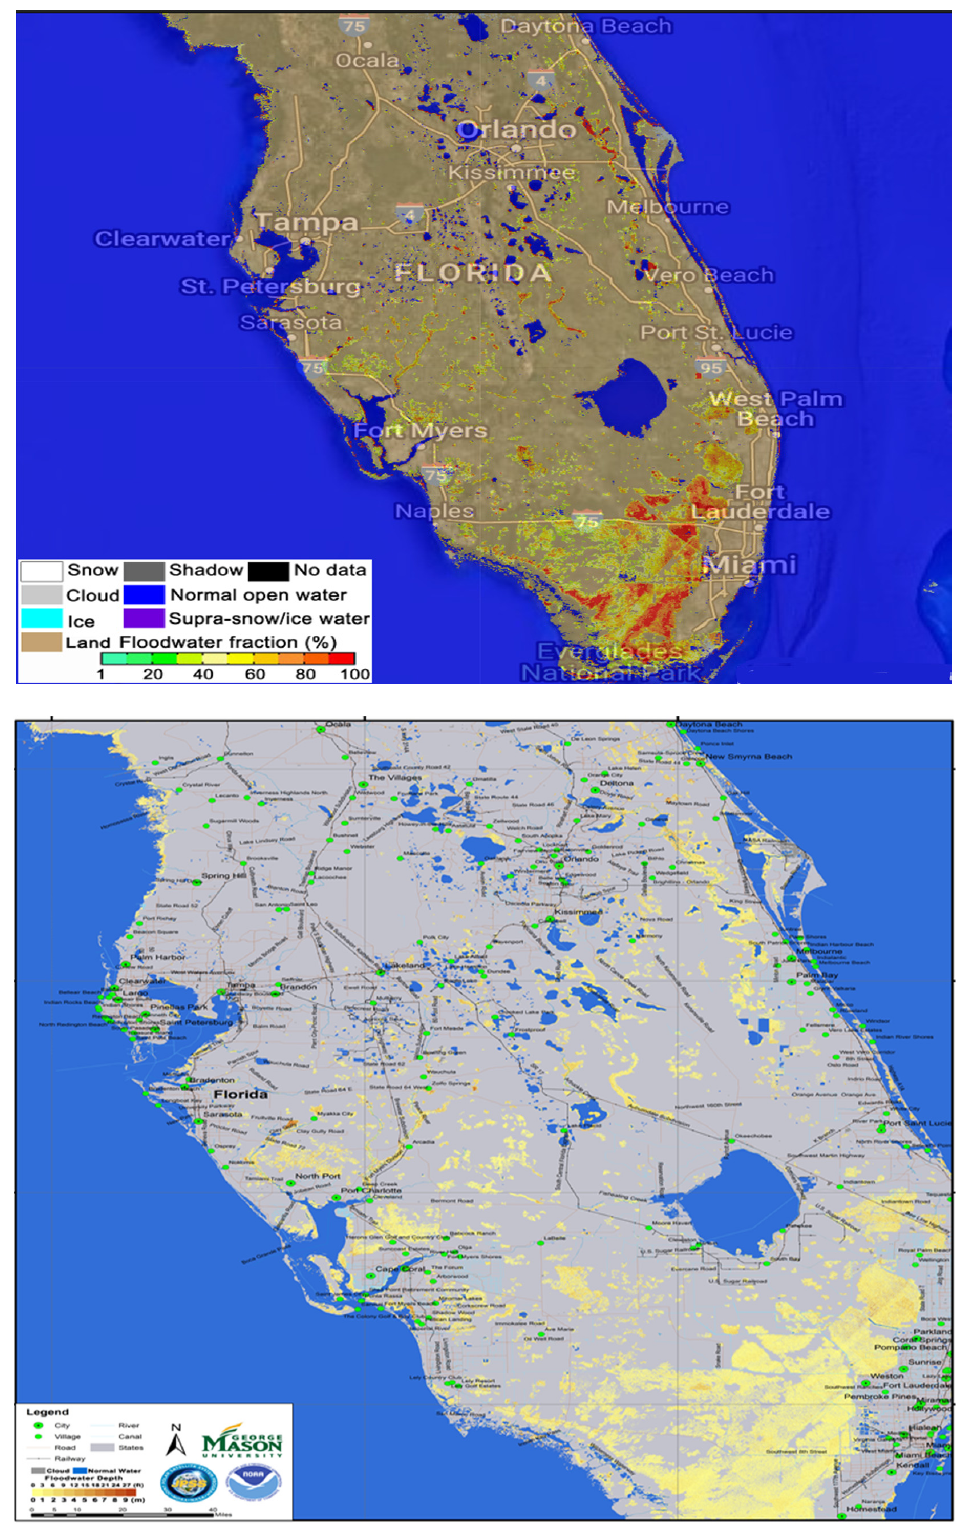
Figure 2. VIIRS flood map at the original 375 m resolution ( upper ) and the downscaled 30 m floodwater depths ( lower ) in Florida due to Hurricane Ian on 30 September 2022.